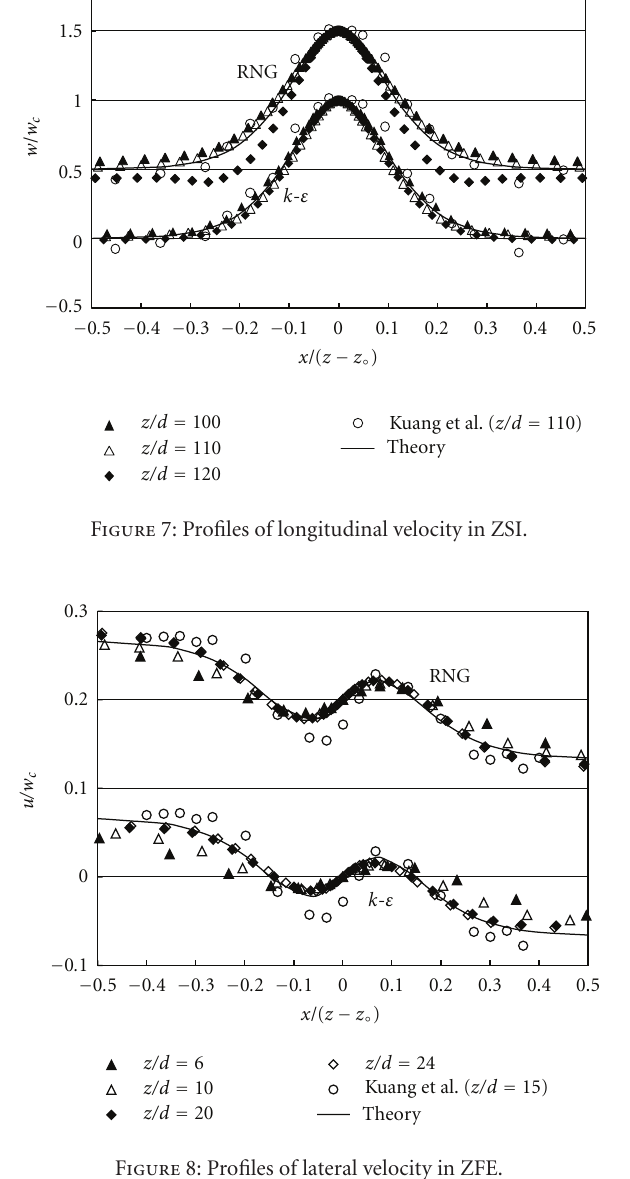
Figure 8: Profiles of lateral velocity in ZFE.